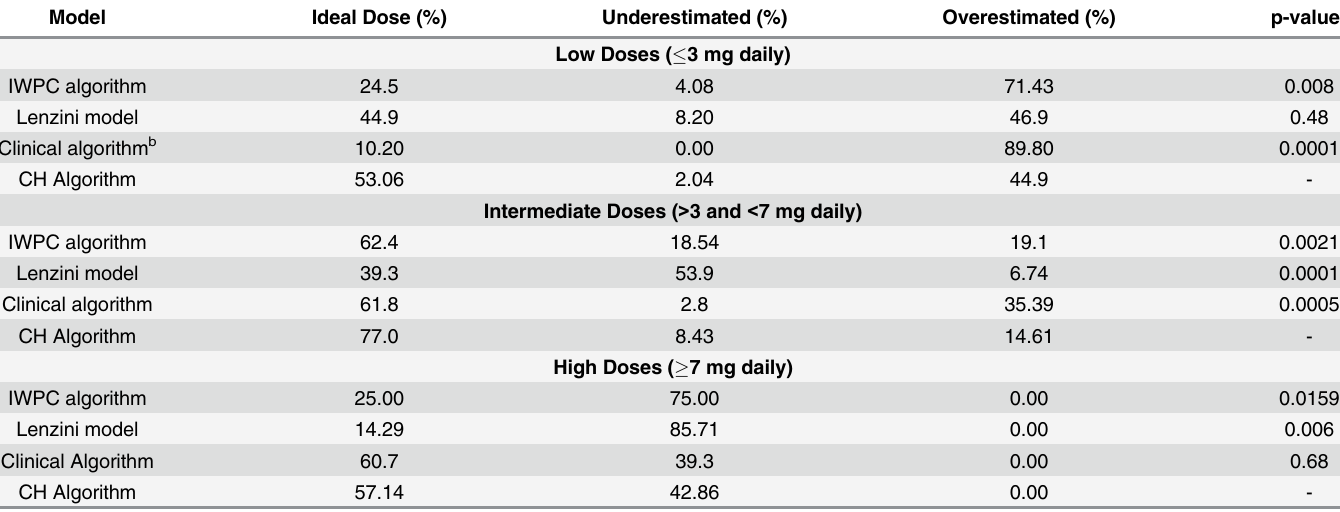
Table 5. Predictions of ideal doses by using the admixture-adjusted pharmacogenetic refinement model developed in Caribbean Hispanics (CH), the Lenzini et al . pharmacogenetic refinement model [36], the IWPC pharmacogenetic initiation algorithm [37] and the clinical algorithm b in patients requiring low ( (cid:4) 3 mg/day), intermediate ( > 3 and < 7 mg/day) or high ( (cid:1) 7 mg/day) exposure. Ideal dose is defined as within 20% of the actual warfarin dose at